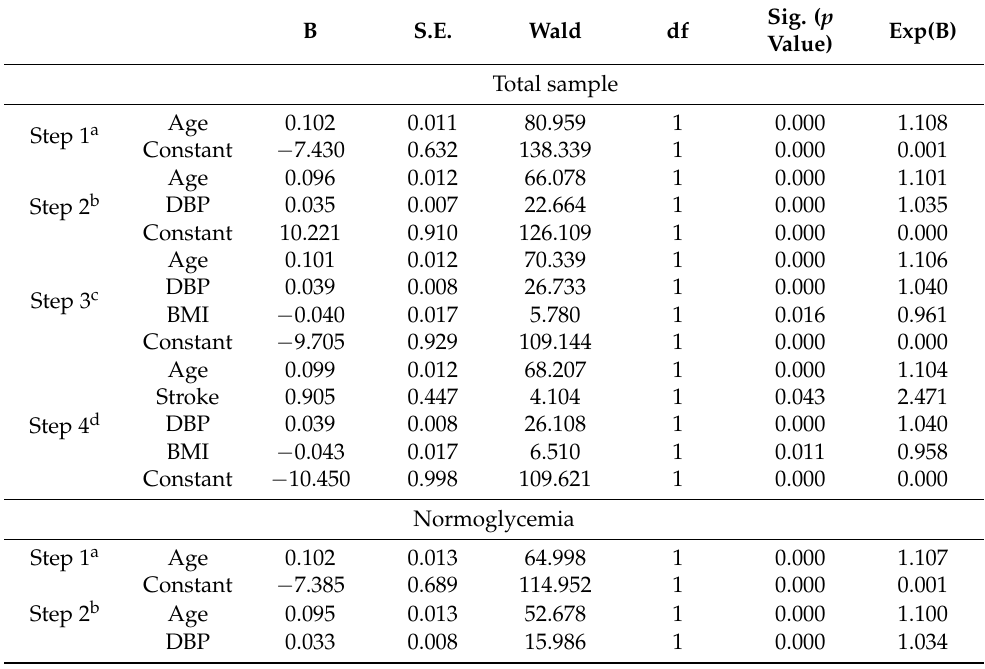
Table 3. Results of binary logistic regression (forward LR method): association of factors with the presence of pathological CAVI ( ≥ 9.0) ( n =